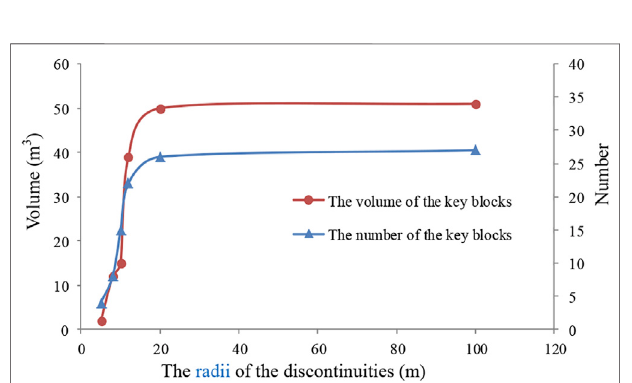
FIGURE 18 | In fl uence of discontinuities radii on key blocks.